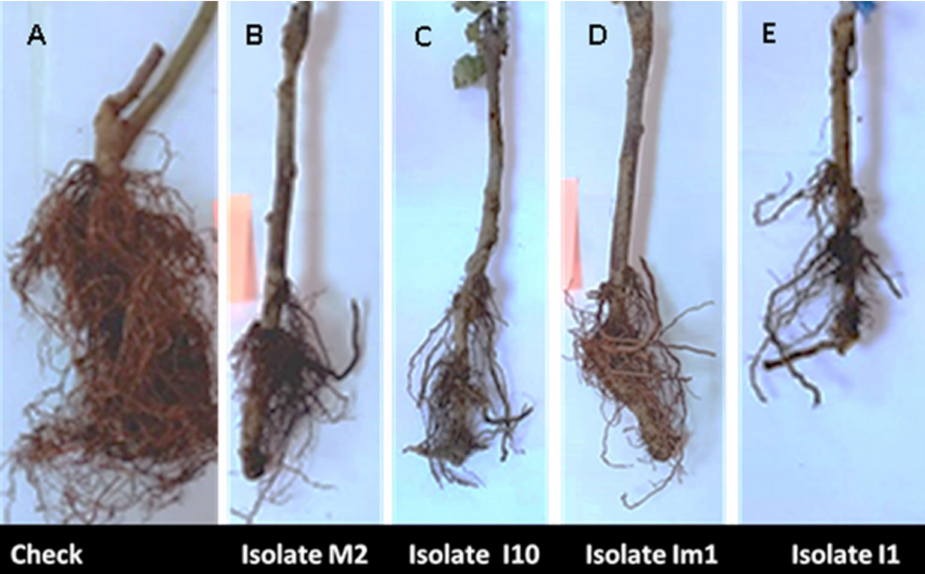
Figure 7. Root rot symptoms in apple rootstock M115 seedlings at the end of the root pathogenicity test (four months post-inoculation) under greenhouse conditions: healthy control (( A ), uninoculated plants); plants inoculated with Phytopythium vexans M2 ( B ), Pp. vexans I10 ( C ), Pp. vexans Im1 ( D ), and Pp. vexans I1 ( E ).